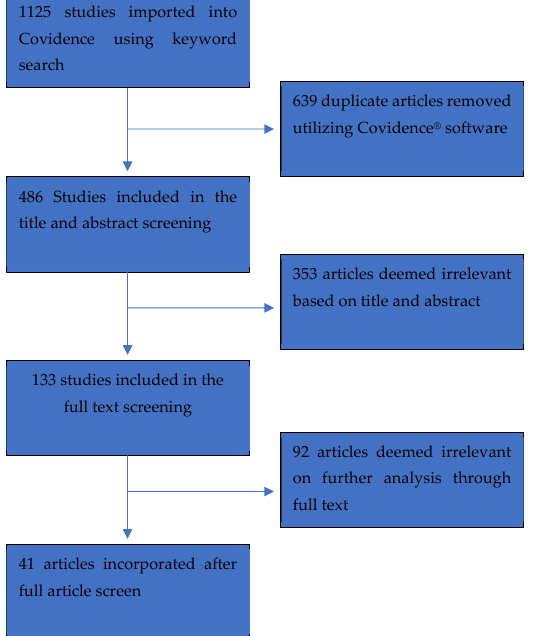
Figure 1. Flow Diagram for Study Screening and Data Collection.